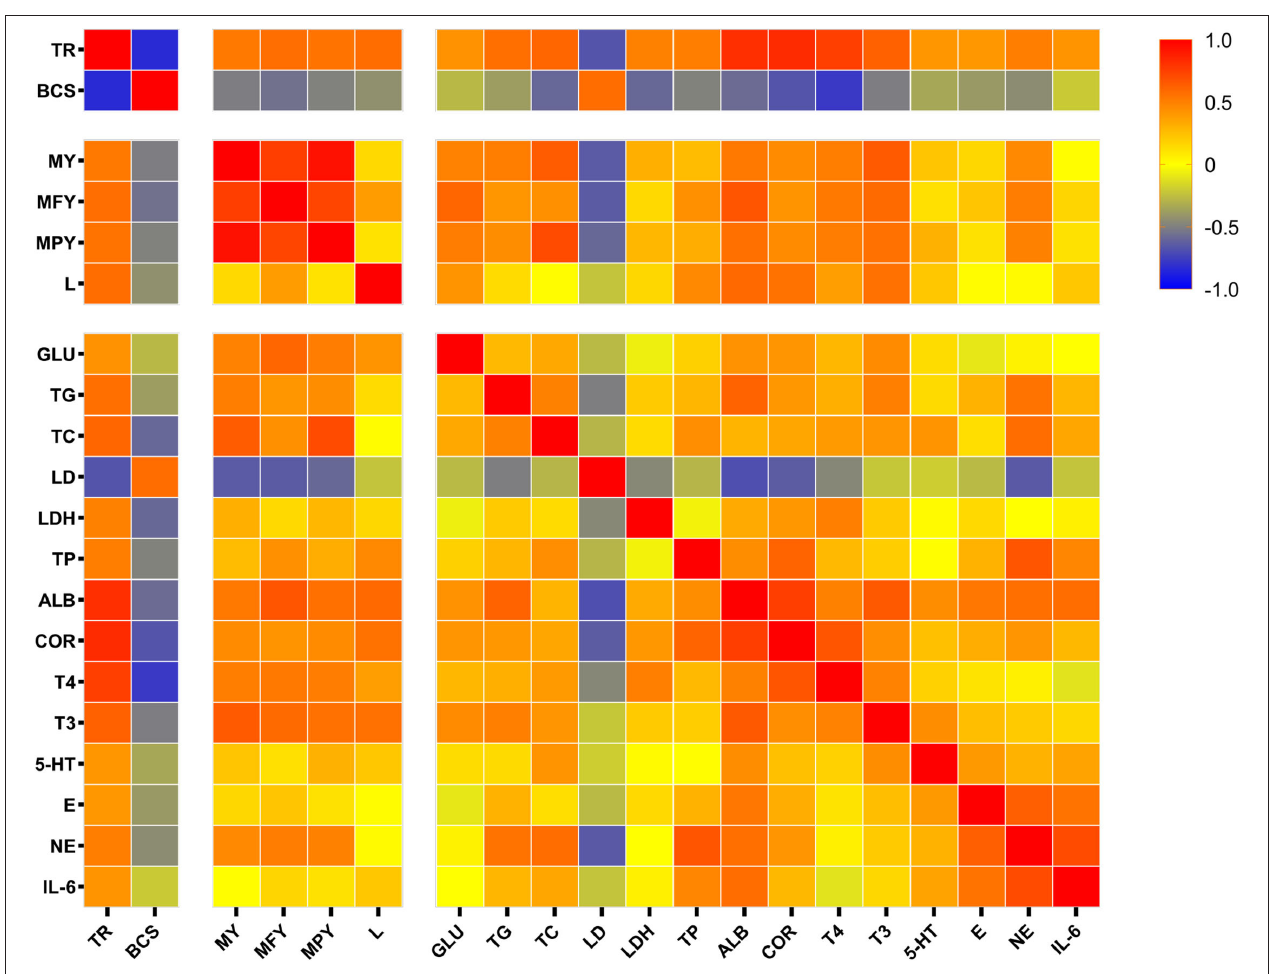
FIGURE 4 | Spearman correlation matrix with r values, from log2 fold change values of the expression of tongue rolling behavior, body condition score, production performance and selected serum indicators in dairy cows. Red indicates a strong positive correlation, blue indicates a strong negative correlation and yellow indicates no correlation. TR, tongue rolling; BCS, body condition score; MY, milk yield; MFY, milk fat yield; MPY, milk protein yield; L, lactose; GLU, Serum glucose; TG, triglycerides; TC, total cholesterol; LD, lactic acid; LDH, lactate dehydrogenase; TP, total protein; ALB, albumin; COR, cortisol; T4, thyroxine; T3, triiodothyronine; 5-HT, serotonin; E, epinephrine; NE, norepinephrine; IL-6, interleukin